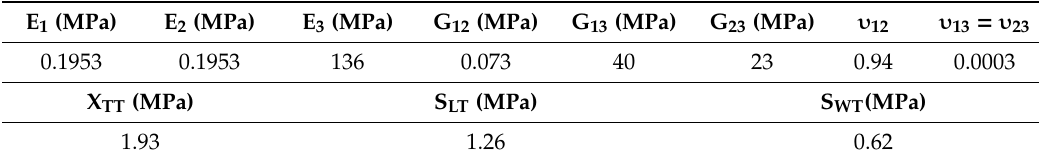
Table 2. Equivalent mechanical properties of Nomex honeycomb.